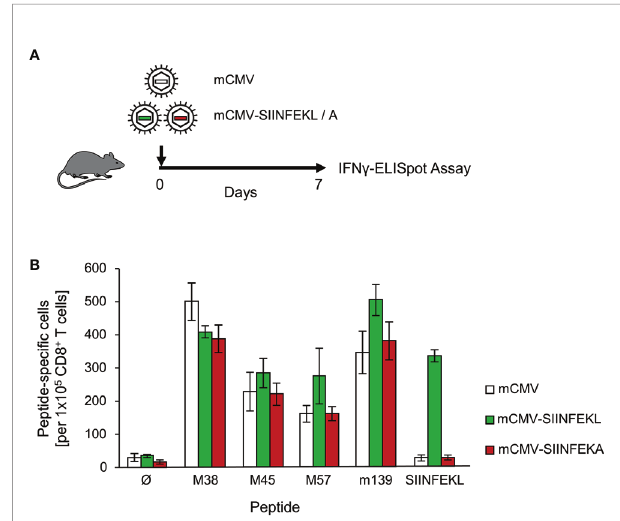
FIGURE 1 | Priming of viral epitope-speci fi c CD8 + T cells. (A) Experimental protocol. On day 7 after intraplantar infection of immunocompetent C57BL/6 mice with 10 5 PFU of the viruses indicated, frequencies of functional, epitope- speci fi c CD8 + T cells present in the spleen (from three mice pooled) were determined by an IFN g -ELISpot assay. (B) Frequencies of primed cells speci fi c for the epitopes indicated. For stimulation in the assay, EL-4 cells were exogenously loaded with the corresponding synthetic antigenic peptides at a saturating concentration of 10 -7 M. (Ø), no peptide loaded. Bars represent numbers of responding cells. Error bars indicate the 95% con fi dence